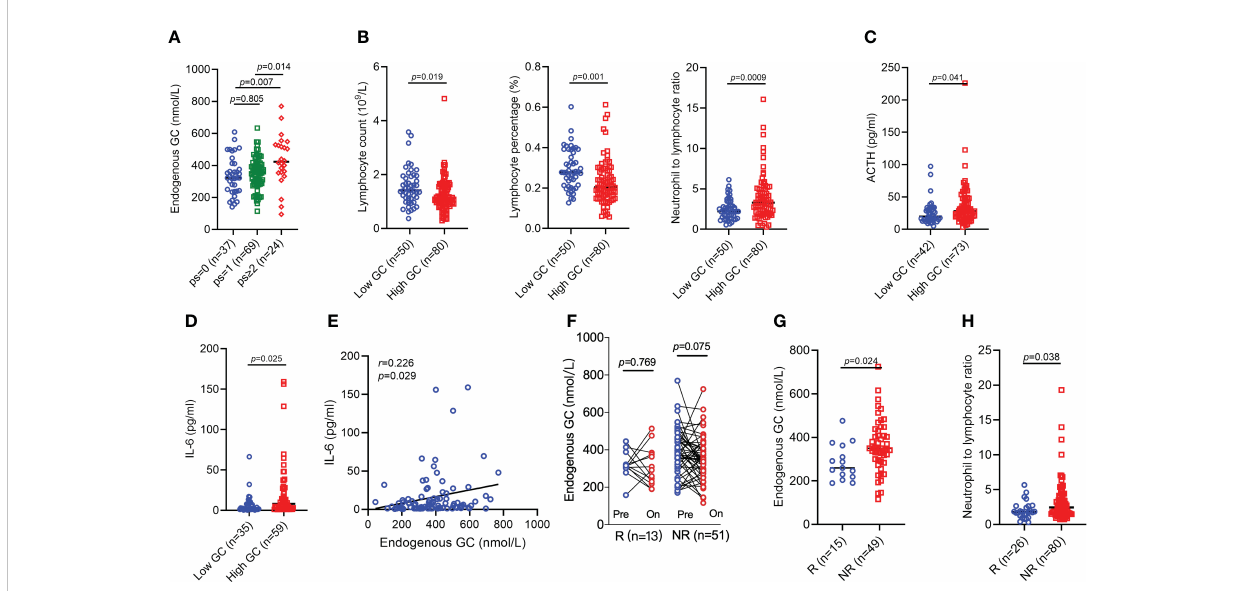
FIGURE 5 Comparing the circulating lymphocytes, cytokines levels, and ACTH levels in patients with high or low endogenous GC levels. (A) The baseline endogenous GC levels in patients with different ECOG PS. (B) The baseline absolute lymphocyte count, lymphocyte percentage, and neutrophil-to- lymphocyte ratio in cancer patients with high or low GC levels. (C) The ACTH levels in patients with high or low GC levels. (D, E) The circulating IL-6 levels in cancer patients with high or low GC levels. (F) Dynamics of endogenous GC (cycles 1-2) in responsive or non-responsive patients. (G) Comparing the endogenous GC levels in all advanced cancer patients with response and patients with no response at the time of the fi rst evaluation (cycle 2). (H) Comparing the neutrophil-to-lymphocyte ratio in all advanced cancer patients with response and patients with no response at the time of the fi rst evaluation (cycle 2). ACTH, adrenocorticotropic hormone; GC, glucocorticoid; ECOG, Eastern Cooperative Oncology Group; PS, performance status; IL-6, interleukin